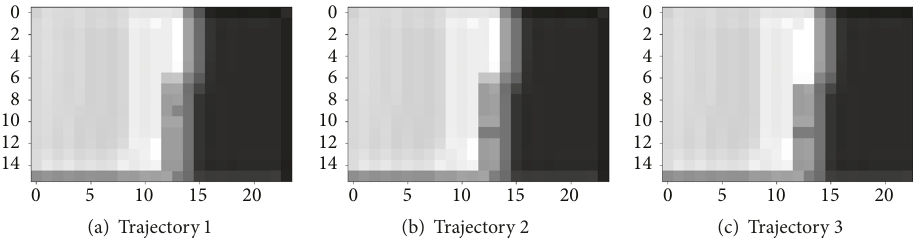
Figure 11: The 𝐺𝑈 representation in different trajectory 3 of the line tracing robot.